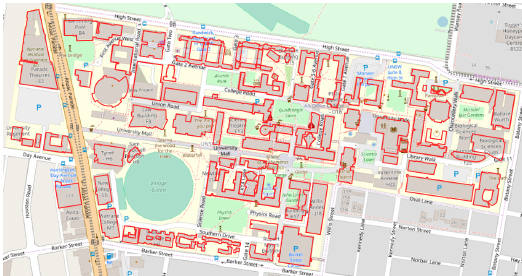
Figure 9. The 2D map and building footprints of the UNSW